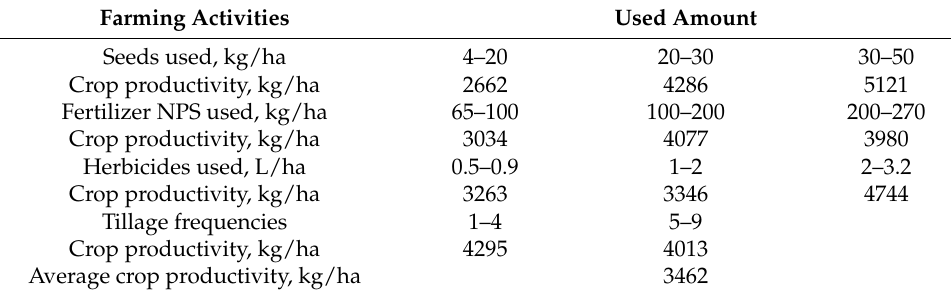
Table 3. Farmers’ decisions in use of farming activities and